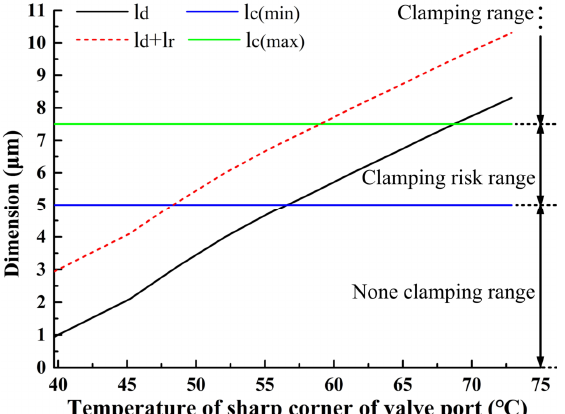
Figure 17. Evaluation of spool clamping caused by thermal deformation.